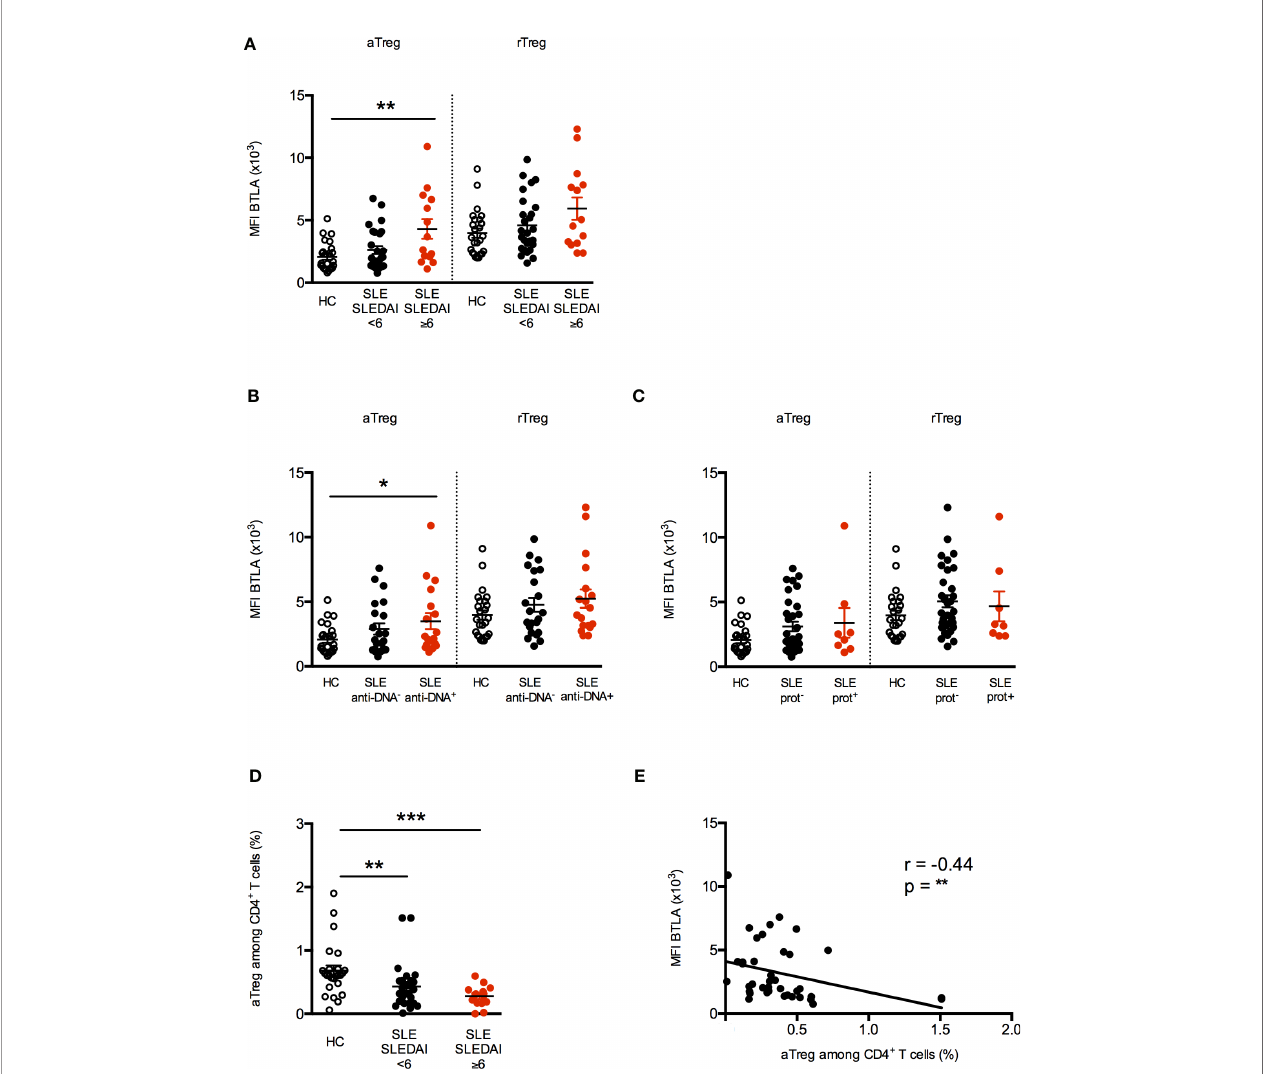
FIGURE 3 | Increased BTLA expression correlates with decreased aTregs frequency in active SLE patients. (A) BTLA expression on aTregs and rTregs in HC (white dots, n=25), patients with inactive SLE or with low activity (SLEDAI <6; black dots, n=27) and patients with mild to severe SLE (SLEDAI ≥ 6; red dots, n=14). (B) BTLA expression on aTregs and rTregs in HC (white dots, n=25), SLE patients without @DNA Abs (black dots, n=22) and SLE patients with @DNA Abs (red dots, n=18). (C) BTLA expression on aTregs and rTregs in HC (white dots, n=25), SLE patients without proteinuria (black dots, n=32) and SLE patients with proteinuria (red dots, n=8). (D) Frequency of aTregs among CD4 + T cells from HC (white dots, n=25), patients with inactive SLE or with low activity (SLEDAI <6; black dots, n=27) and patients with mild to severe SLE (SLEDAI ≥ 6; red dots, n=14). Results are expressed as mean ± SEM and each dot represents one individual. (E) Correlation between BTLA expression (MFI) and the percentage of aTregs among CD4 + T cells (n=40). *p < 0.05; **p < 0.01; ***p < 0.001, Mann-Whitney test; r, Spearman correlation coef fi